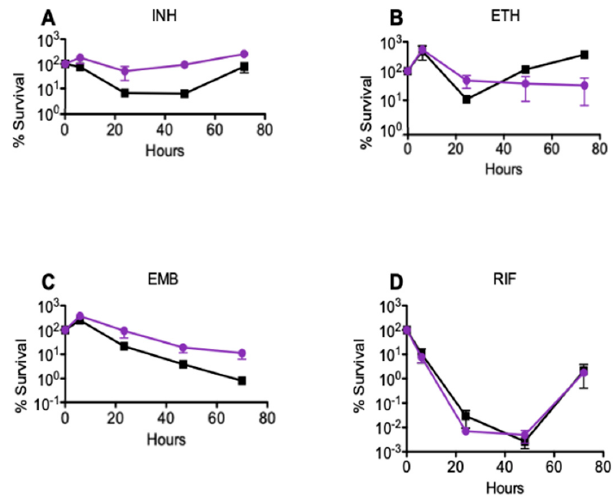
Figure 2. Response of the msm2570::Tn transposon mutant to antibiotics in batch cultures. M. smeg- matis wild-type ( ■ ) and msm2570::Tn mutant (•) strains were treated with ( A ) INH 50 µg mL − 1 , ( B ) smegmatis wild-type ( (cid:4) ) and msm2570::Tn mutant ( • ) strains were treated with ( A ) INH 50 µ g mL − 1 , ETH 200 µg mL − 1 , ( C ) EMB 5 µg mL − 1 , ( D ) RIF 200 µg mL − 1 . Results are the means ± standard er- ( B ) ETH 200 µ g mL − 1 , ( C ) EMB 5 µ g mL − 1 , ( D ) RIF 200 µ g mL − 1 . Results are the means ± standard rors from three independent cultures . errors from three independent